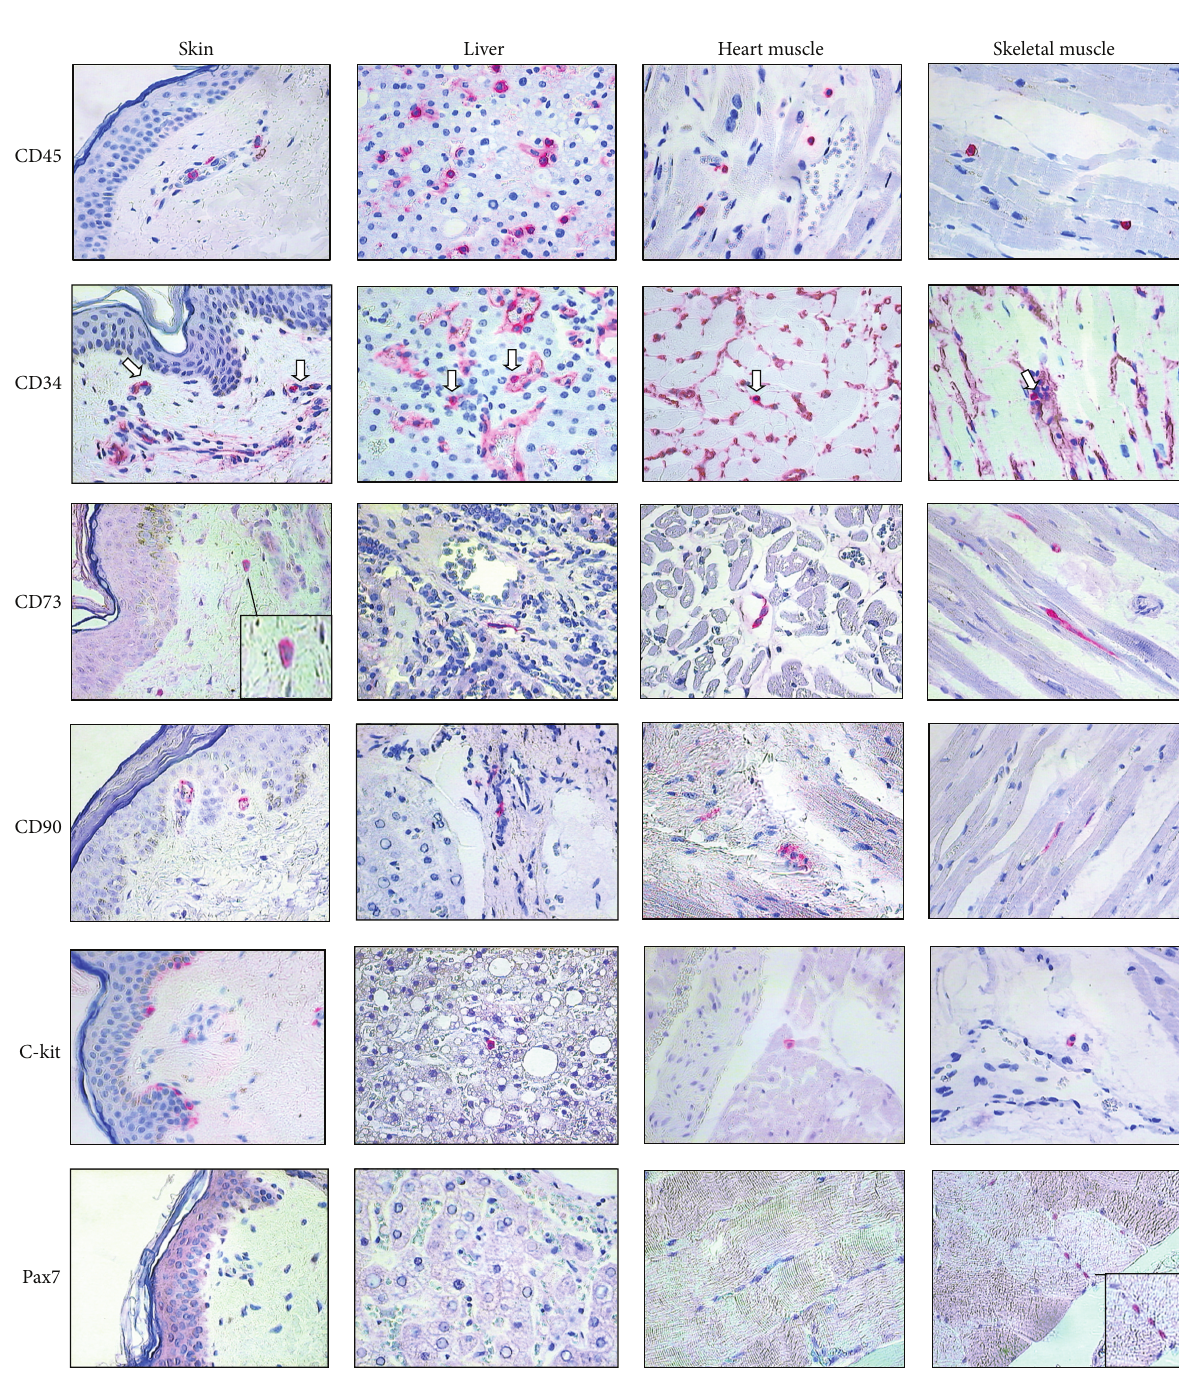
Figure 1: Tissue distribution and the phenotype of tissue-resident stem cells characterized by immunocytochemistry for CD45, CD34, CD73, CD90,c-kit,andPax7.Tissuesampleswerecollectedfromskin,liver,heart,andskeletalmuscle.ImmunostainingforCD45andCD34(arrows) illustrated the presence of cells of hematopoietic origin in the tissues. Note CD34 positivity on the vessel endothelial cells. Common feature of tissue localized stem cells was expression of CD73, CD90, and c-kit. Skeletal muscle progenitor cells exclusively express transcriptional factor Pax7. CD73, CD90, and c-kit were expressed on single stem cells of examined tissues and were localized in specific tissue compartments: in the basal layer of epidermis, the epithelium of adnexal structure of the skin, the periportal area of the liver, between the basal lamina and sarcolemma of myofibers of the muscle, and were connected to myocytes and fibroblasts in the cardiac